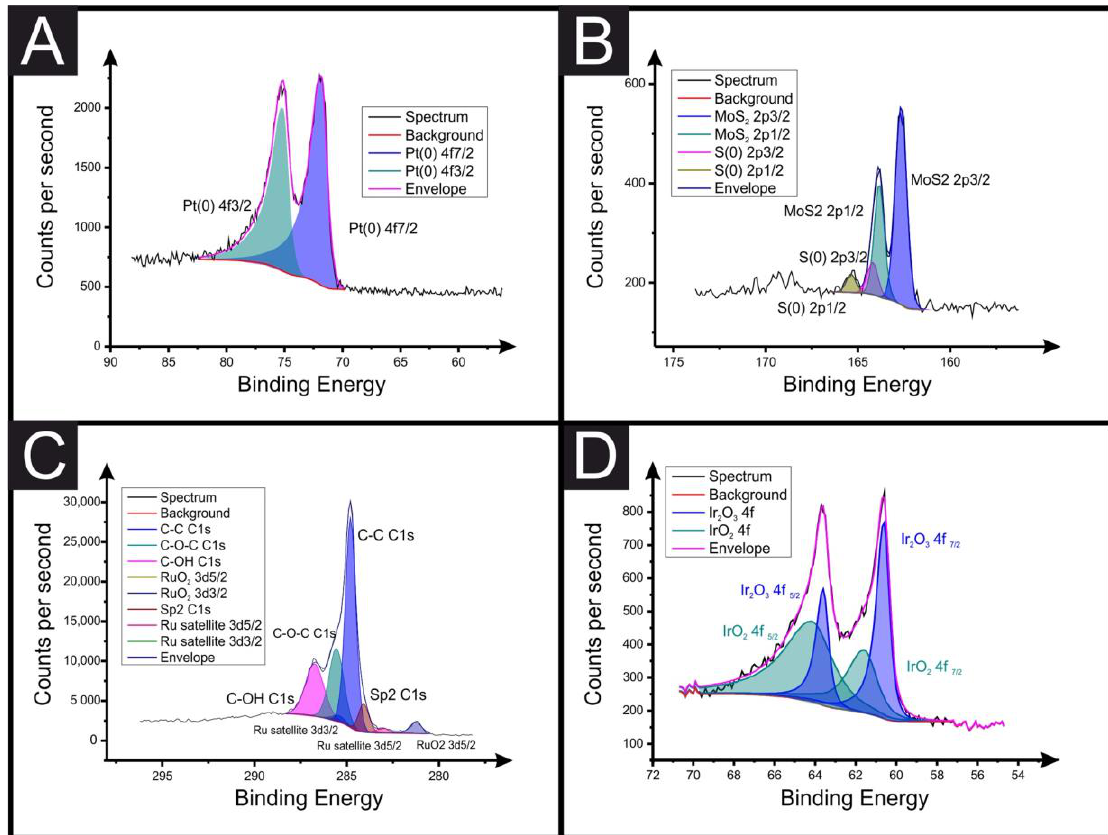
Figure 2. XPS data corresponding to the working electrode surface of the bulk-modified SPEs, highlighting the incorporation of the Pt/C, MoS 2 , RuO 2 and IrO 2 ( A – D , respectively)